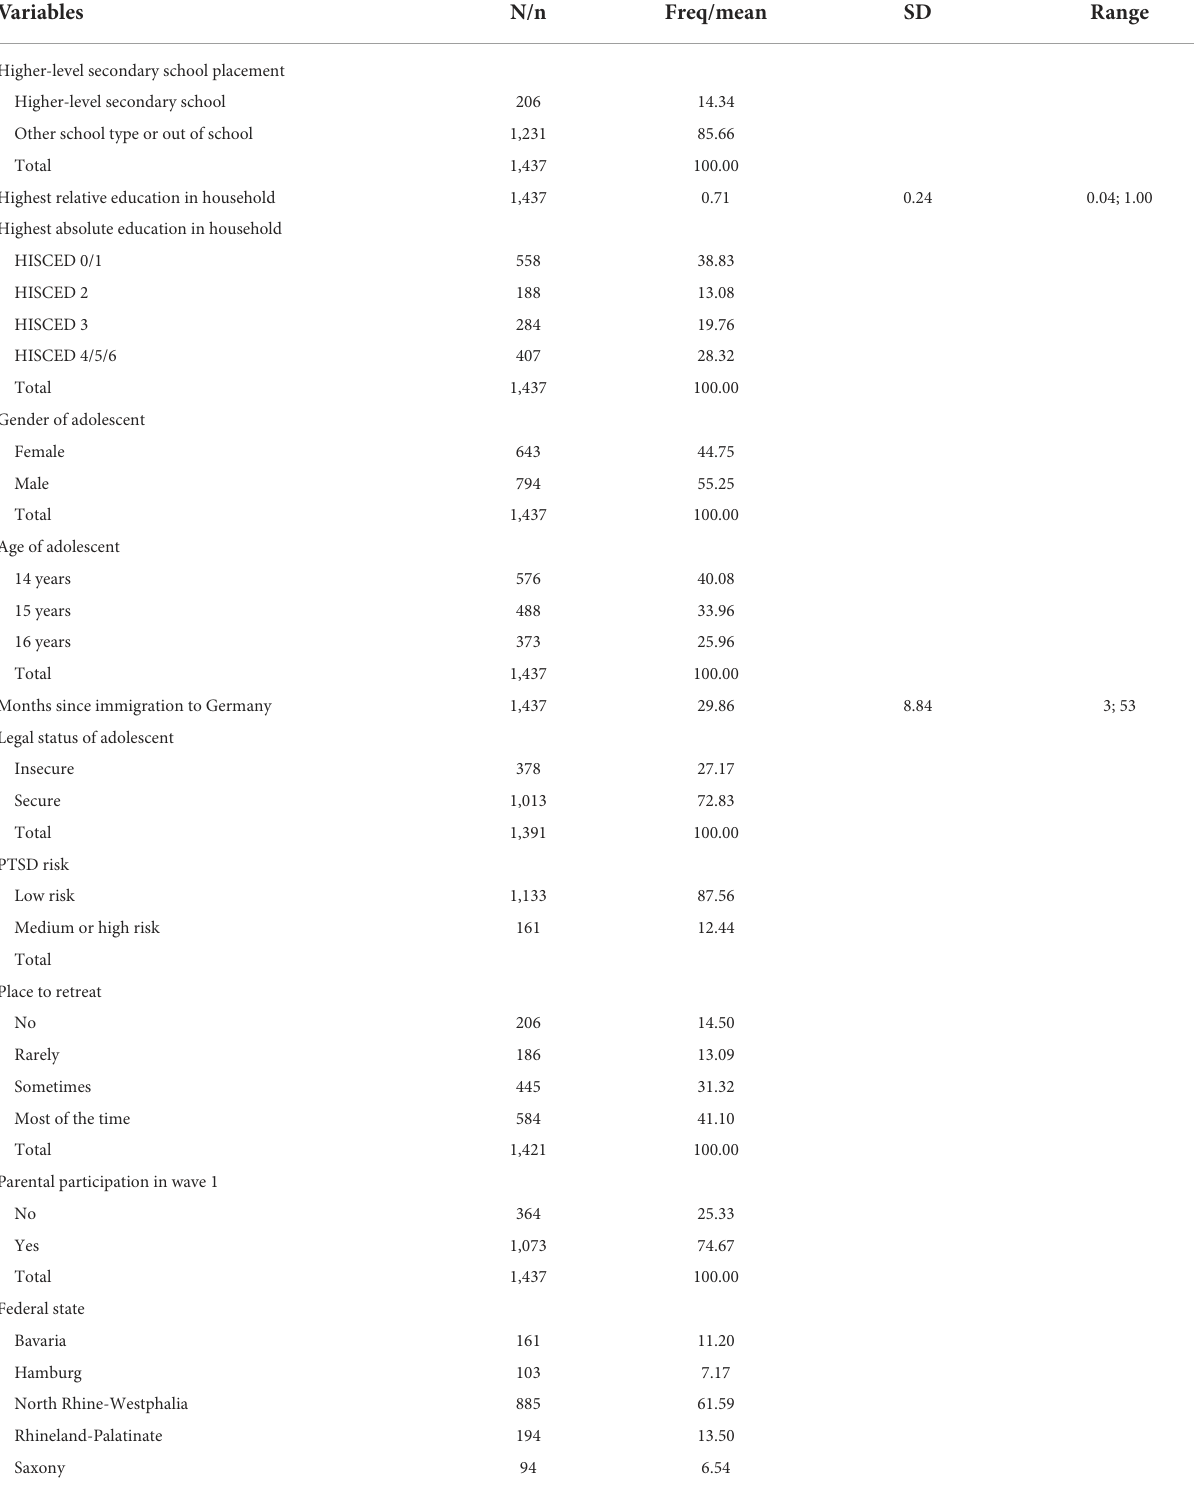
TABLE 1 Descriptive sample characteristics ( N =